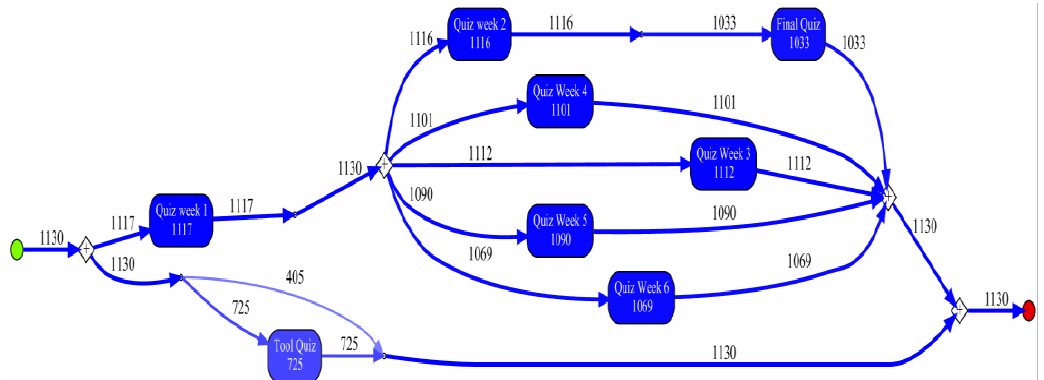
Figure 14. Quiz submission process model for cluster